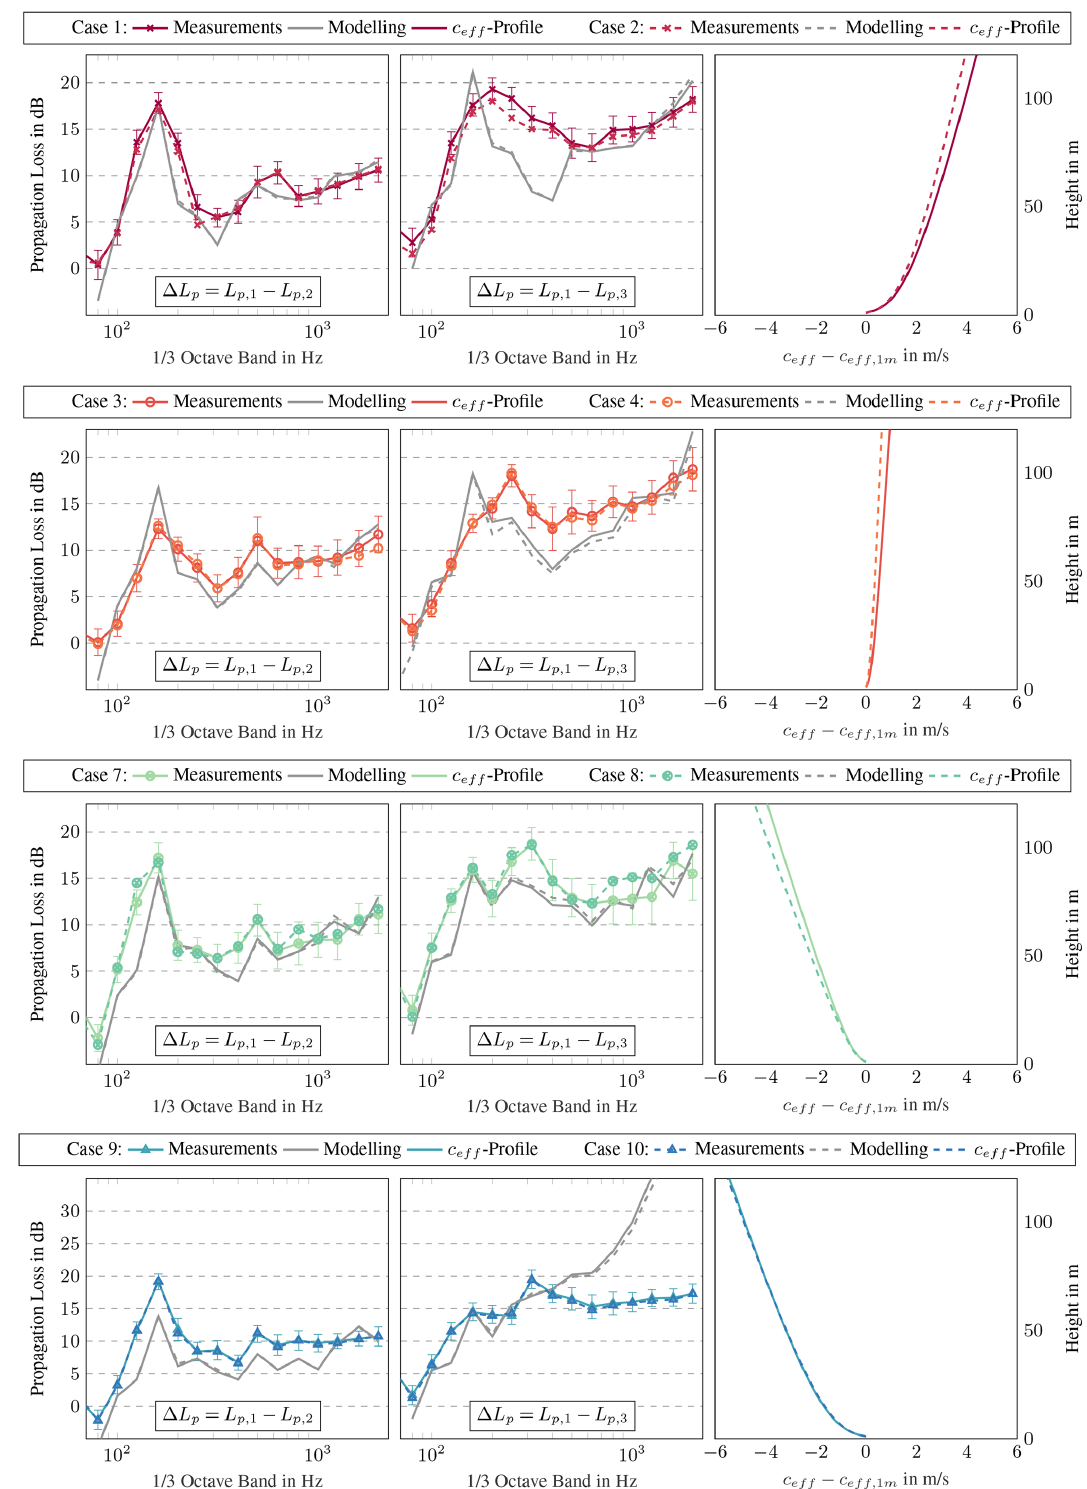
Figure 8. Comparison of measured and modelled sound propagation losses per one-third octave band for cases 1 to 4 and 7 to 10. Left: propagation losses between Mic 1 (178m) and Mic 2 (535m) including standard deviation for one measurement case. Middle: propagation losses between Mic 1 (178m) and Mic 3 (845m) including standard deviation for one measurement case. Right: normalised profiles of effective sound